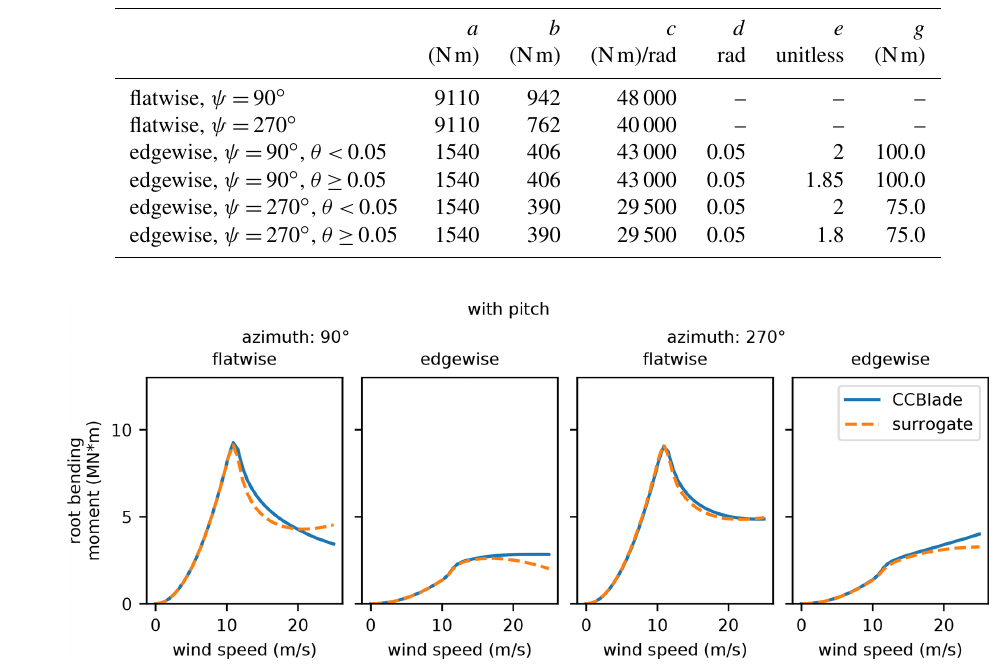
Figure 4. The surrogate fit for the root bending moments. From left to right, the R 2 value of each fit is 0.966, 0.939, 0.995, and 0.967,